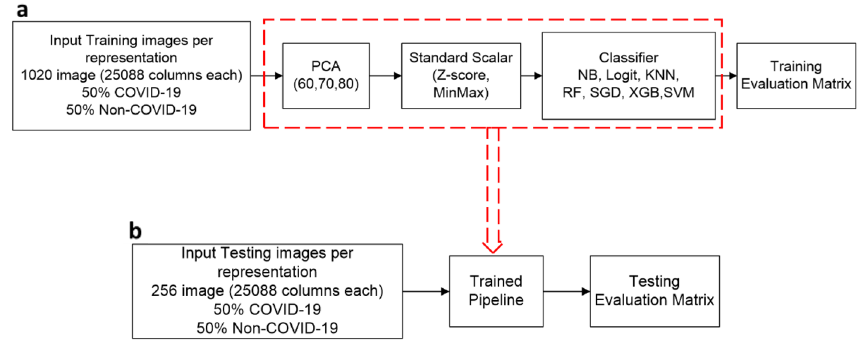
Figure 3. Training and testing pipelines for the shallow machine learning models used in our study. ( a ) Training pipeline: The input training images per representation are scored against the vgg19 (pre-trained model) to extract features automatically. Each representation has 1020 images in the training data, where 50% of the training data labels are COVID-positive, and the remaining 50% are negative. The features’ size is 25,088, and we further select the essential features using a principal component analysis (PCA) processing step to select either 60, 70, or 80 features. The selected features are then normalized using either Z-score or MinMax standard scalars. Then the normalized features are used to train seven classifiers (Naïve Bayes (NB), Logistic Regression (Logit), K-nearest neighbours (KNN), Random Forest (RF), Stochastic Gradient Descent (SGD), Extreme Gradient Boosting (XGB), and Support Vector Machine (SVM). We measure and record the training evaluation results to choose the best classifiers. ( b ) Testing pipeline: Once the training process is completed, we score the testing data against each trained pipeline. The trained pipeline is composed of the best PCA, standard scalar, and classifier parameters. The testing data has 256 images per representation with equal labels for both COVID- positive and negative cases. We measure and record the testing evaluation results to estimate the generalization error of each